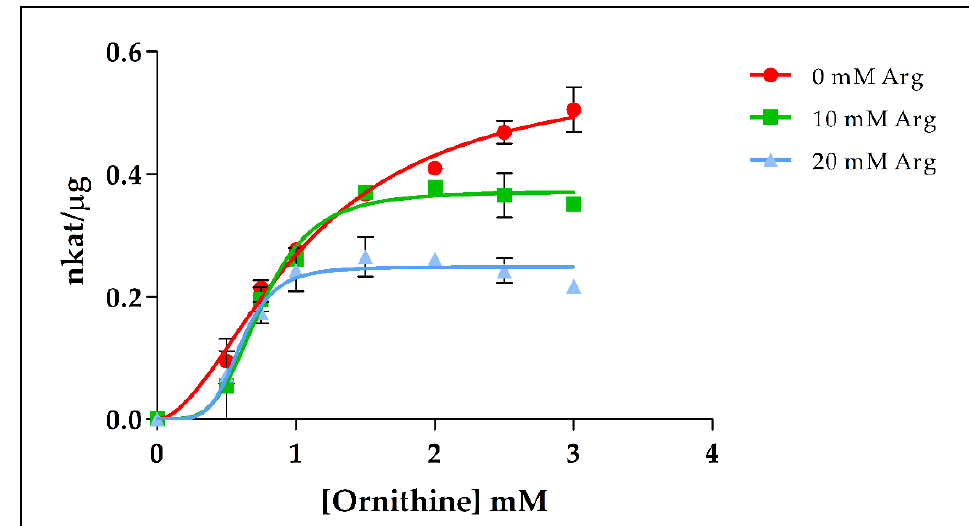
Figure 6. Allosteric inhibition of PpOTC by arginine. The figure shows how the presence of arginine modifies the PpOTC activity, reducing V max but increasing the affinity of the enzyme for ornithine. Values: 0 mM Arg: S 0.5 = 1.12 ± 0.23 mM, V max = 0.57 ± 0.05 nkat/μg; 10 mM Arg: S 0.5 = 0.32 ± 0.08 mM, Table 2. IC50 values for PpOTC, PpASSY and PpASL activity inhibitor compounds. Enzyme Compound IC50 Value (mM) arginine 10.28 PpOTC 7.19 PpASSY